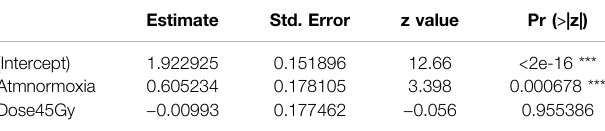
TABLE 6 | Fixed effects of irradiation in anoxia on fl ight ability. Estimate